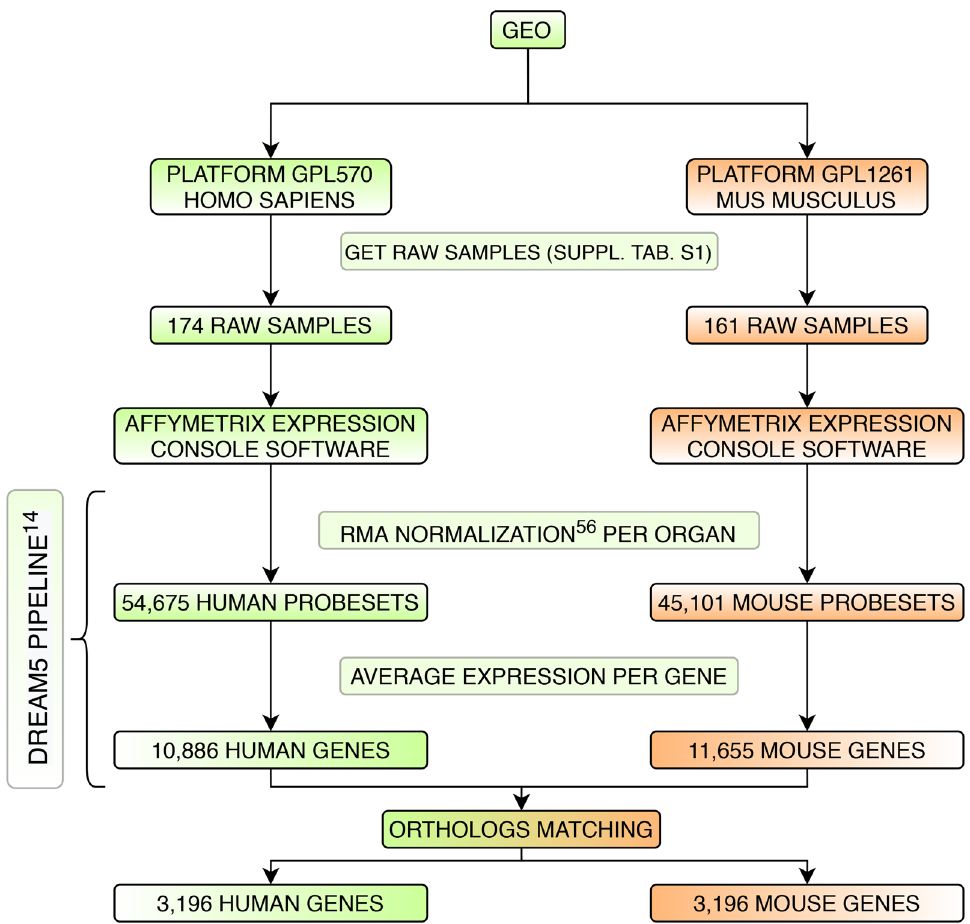
Figure 4. Graphical overview of the pipeline followed to identify the genesets and their gene expression levels.